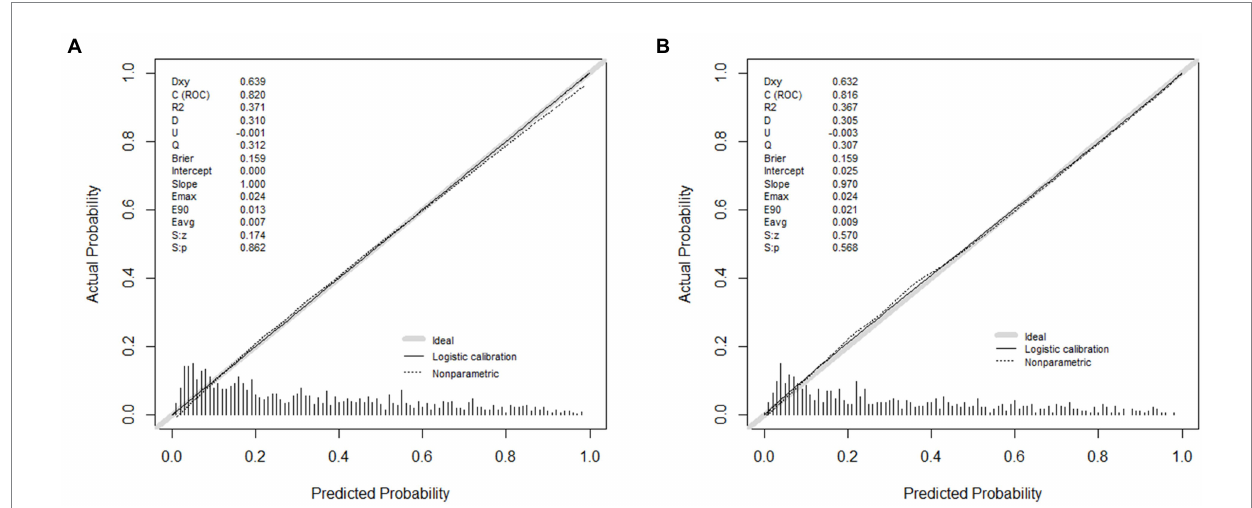
FIGURE 4 Calibration curve of constructed nomogram in the developing set (A) and verification set (B) . The actual mortality was consistent with the predicted mortality in the developing ( p = 0.862) and verification ( p = 0.568)